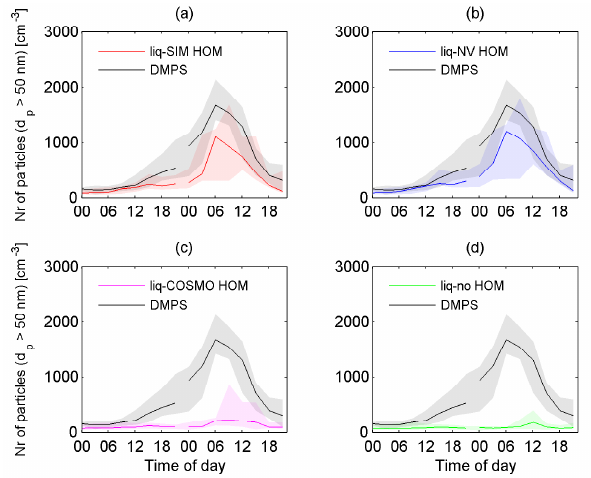
Figure 4. Median number of particles above 7nm of all chosen NPF events at Pallas (from midnight on the day of the event to the evening the day after the start of the event) together with the 25 and 75 percentiles (shaded areas). The black lines are the median DMPS data from Pallas. The colored lines in (a–c) are the modeled median number of particles above 7nm, using different methods to estimate the vapor pressures of the HOMs (see Table 1). In (d) , HOMs are excluded.